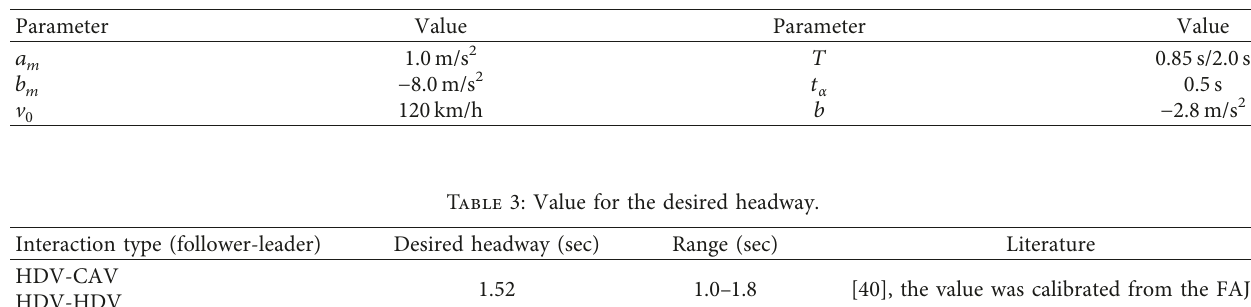
Figure 1: Architecture of the study on safety impacts of CAV’s exclusive lanes. Table 2: Parameter values of the IDM model.